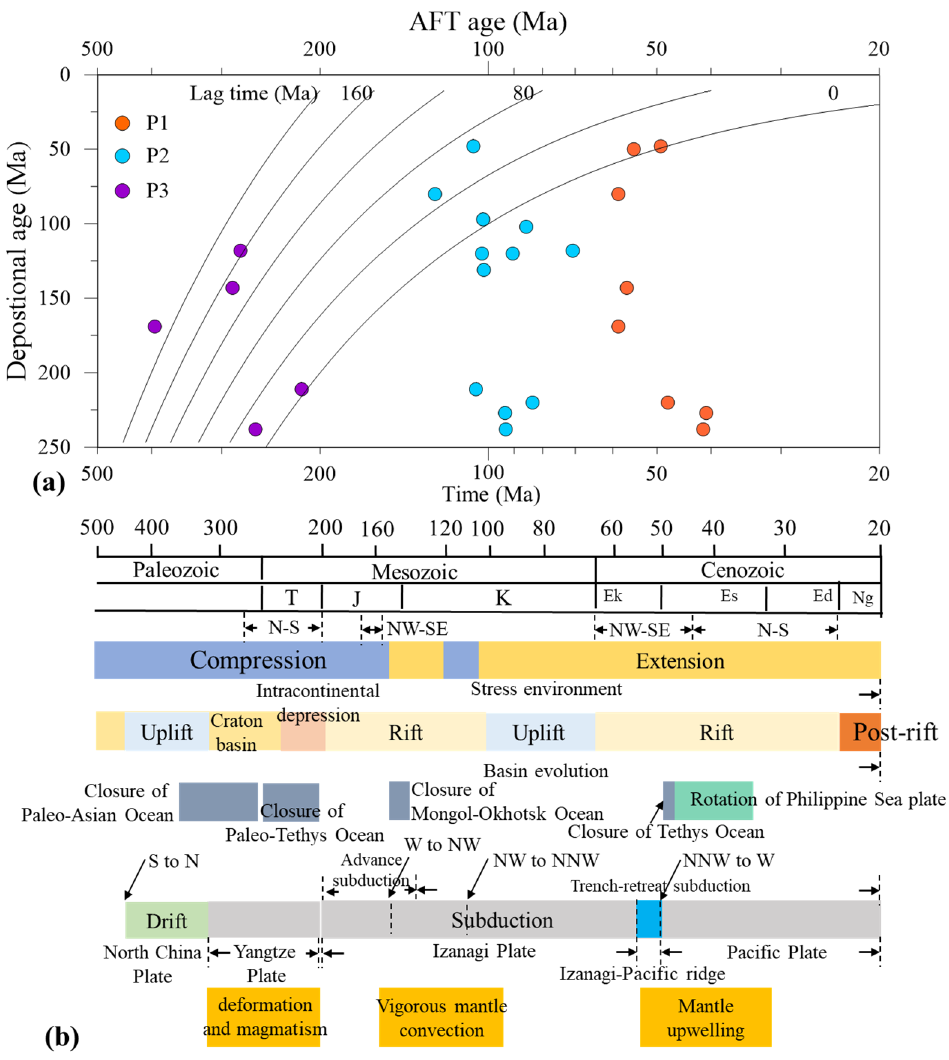
Figure 6. ( a ) Grain age components of apatite fission track from the Linqing Depression P1–P3 are age peaks in Table 2. ( b ) Tectonic evolution of the Linqing Depression, stress environment [46,52–55]; basin evolution [32,46,56,57]; plate activity [46,50,51,56,58–61]; mantle activity [13,15,46,52].